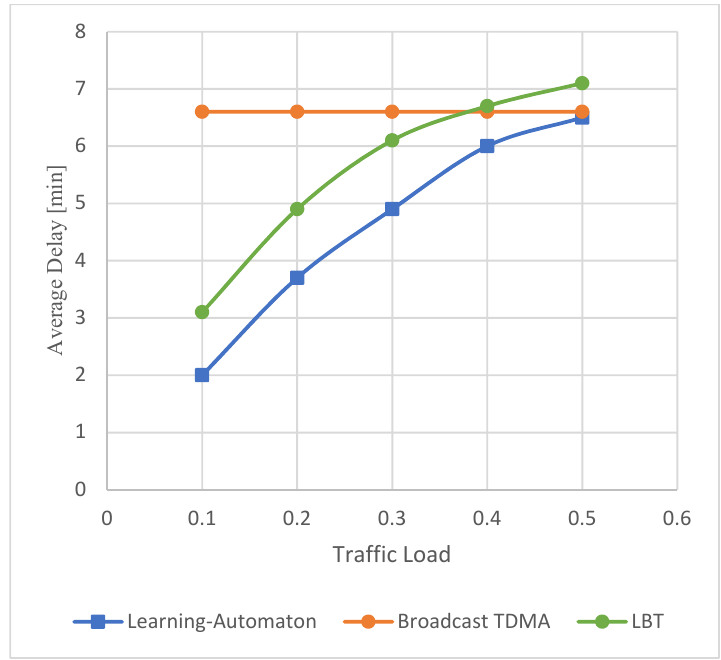
Figure 5. Average delay versus traffic load characteristics.